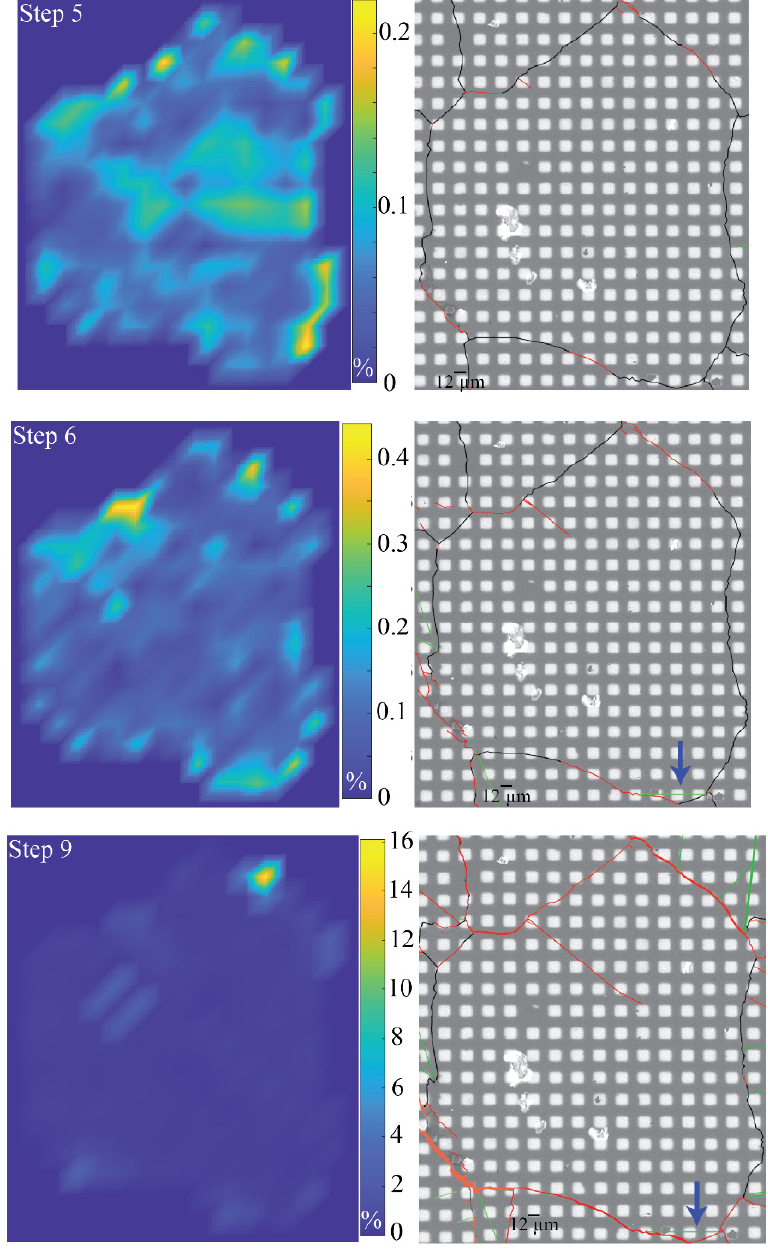
Figure 22. Equivalent Von Mises deformation map of crystal 16 at different steps of sample defor- mation. The black lines represent the grain boundaries. The green lines show the twinned planes. The red lines show the fracture zones. The blue arrow is indicating the location of the twinned plane.